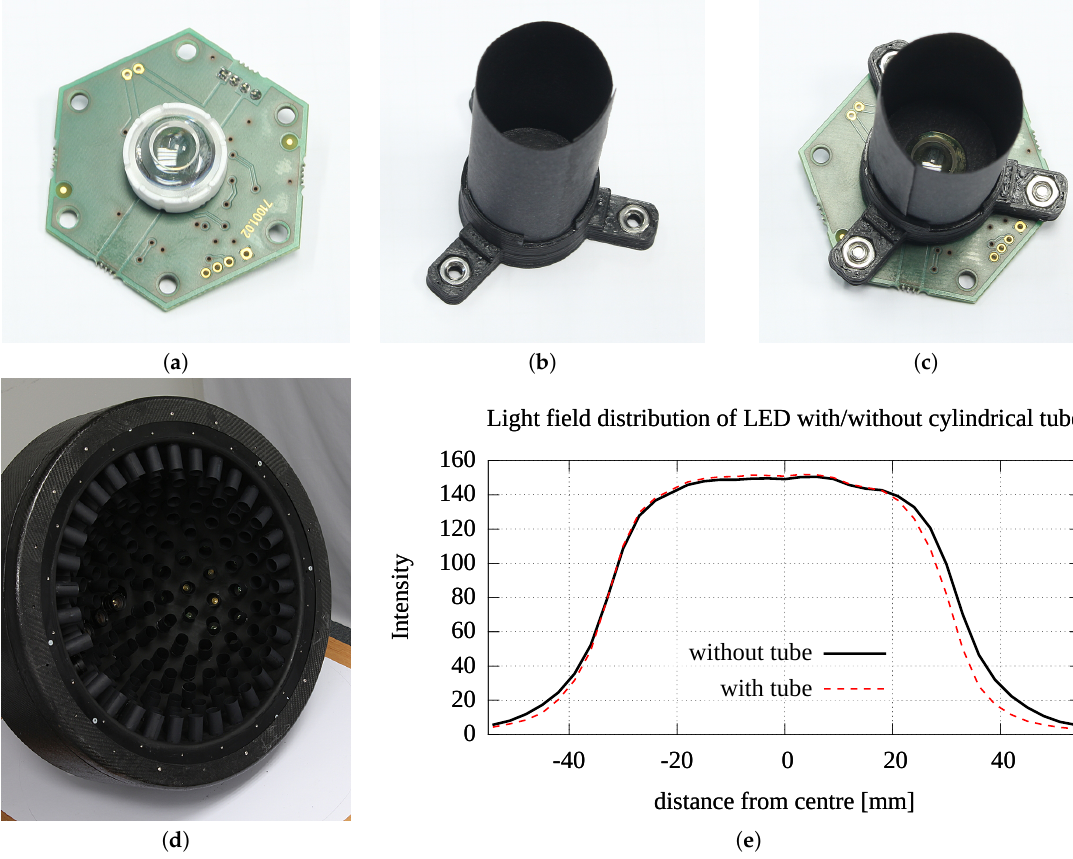
Figure 11. LED module: ( a ) PCB with lens; ( b ) tube mounted on the holder; ( c ) the assembled unit with three adjusting screws to get required direction; ( d ) photograph of the assembled PMMA dome showing the baffler created by the structure of tubes that effectively diminishes stray light inside the dome; ( e ) the illumination intensity distribution at 250 mm distance from the LED module with the tube and without